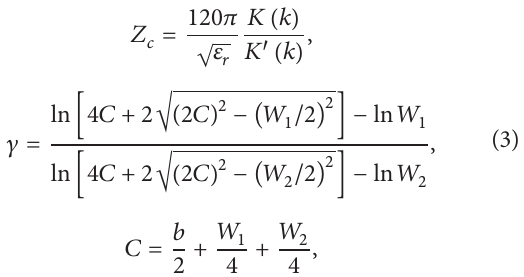
Figure 2: The schematic diagram of strip asymmetric folded dipole.